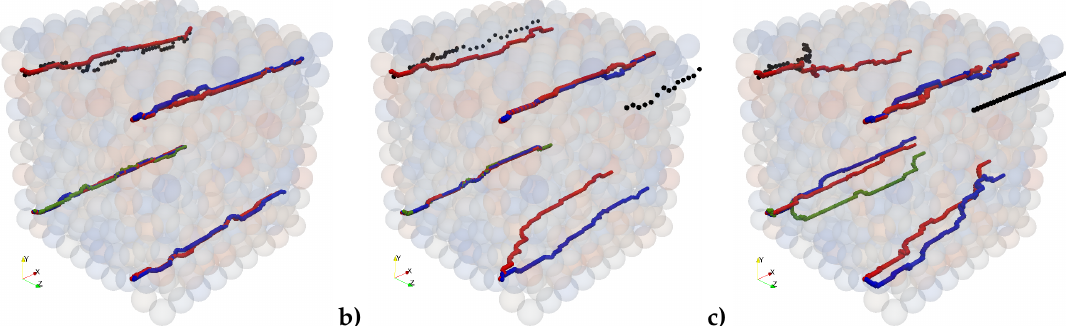
Figure 14. Impact of grid resolution on the results: A-Star static ( a ), A-Star dynamic ( b ), and Path Searching Algorithm (PSA) ( c ).